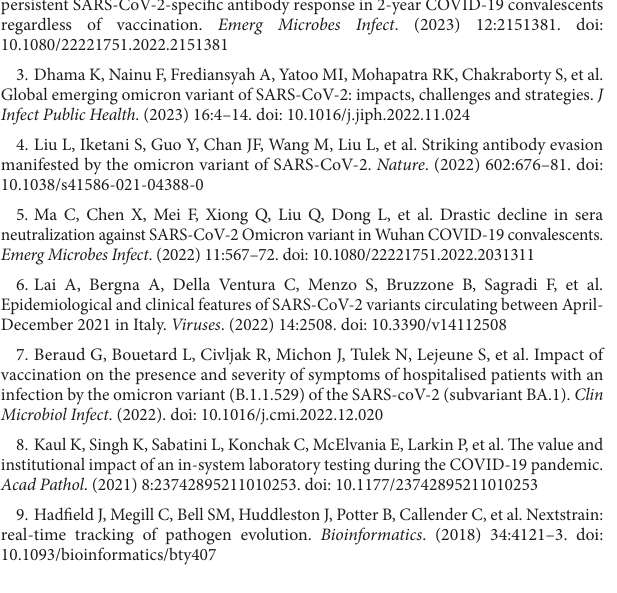
SUPPLEMENTARY FIGURE S1 Lack of Correlation Between Library Pool Molarity and Percentage of Samples Generating a Consensus